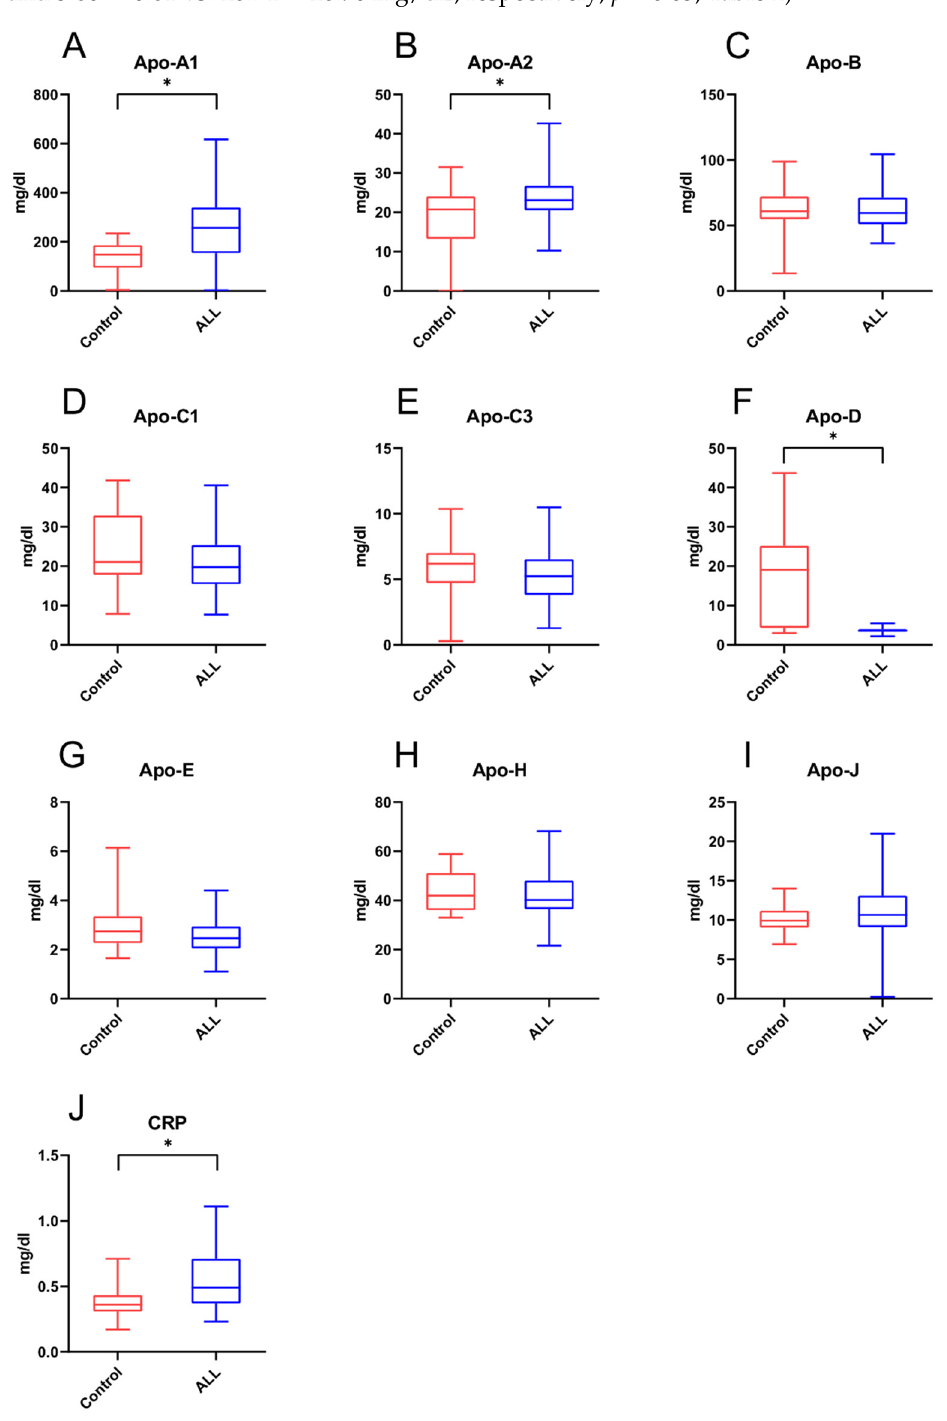
and 3.60 ± 0.61 vs. 28.74 ± 28.90 mg/dL, respectively; p < 0.05; Table 2).